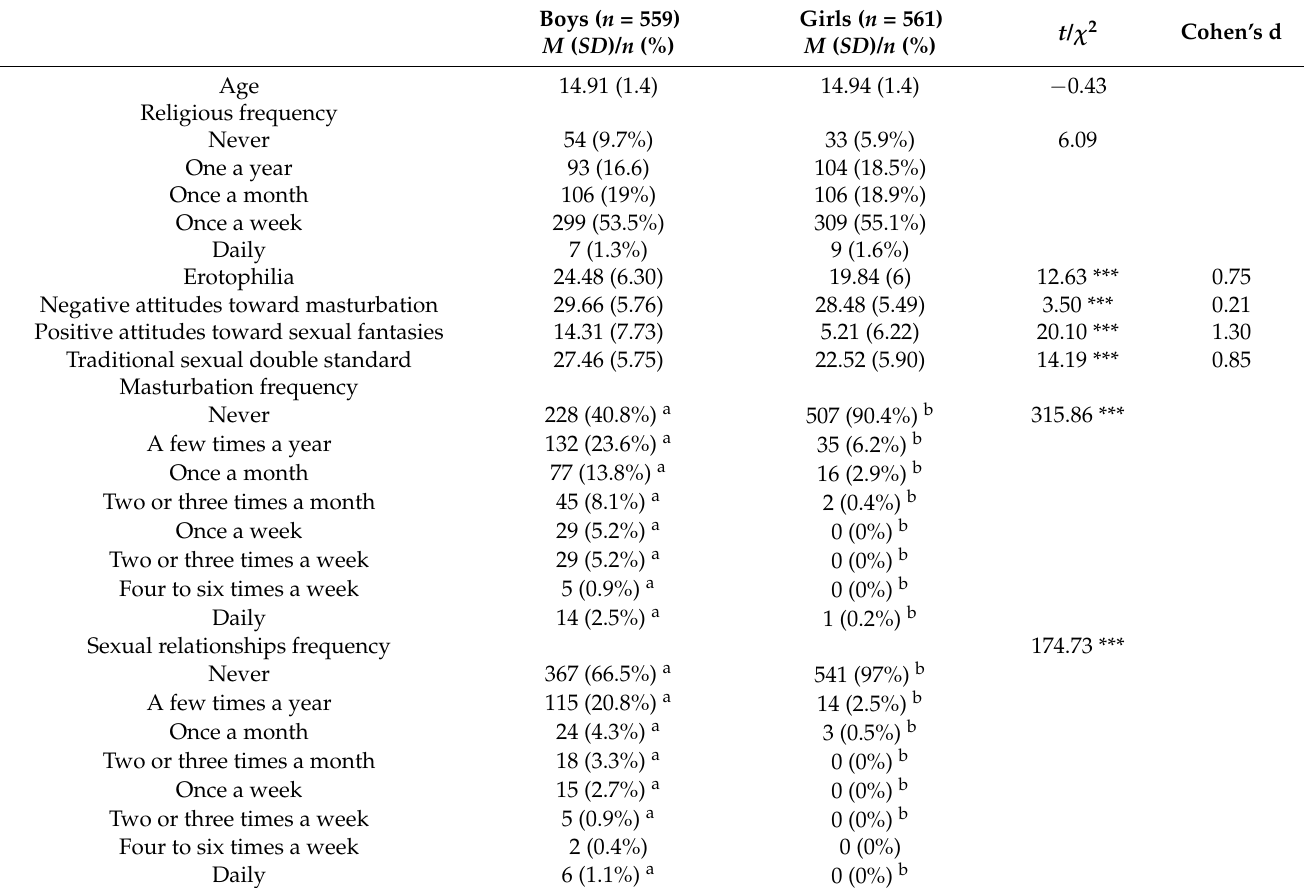
Table 2. Differences between the sexes in the observed variables.